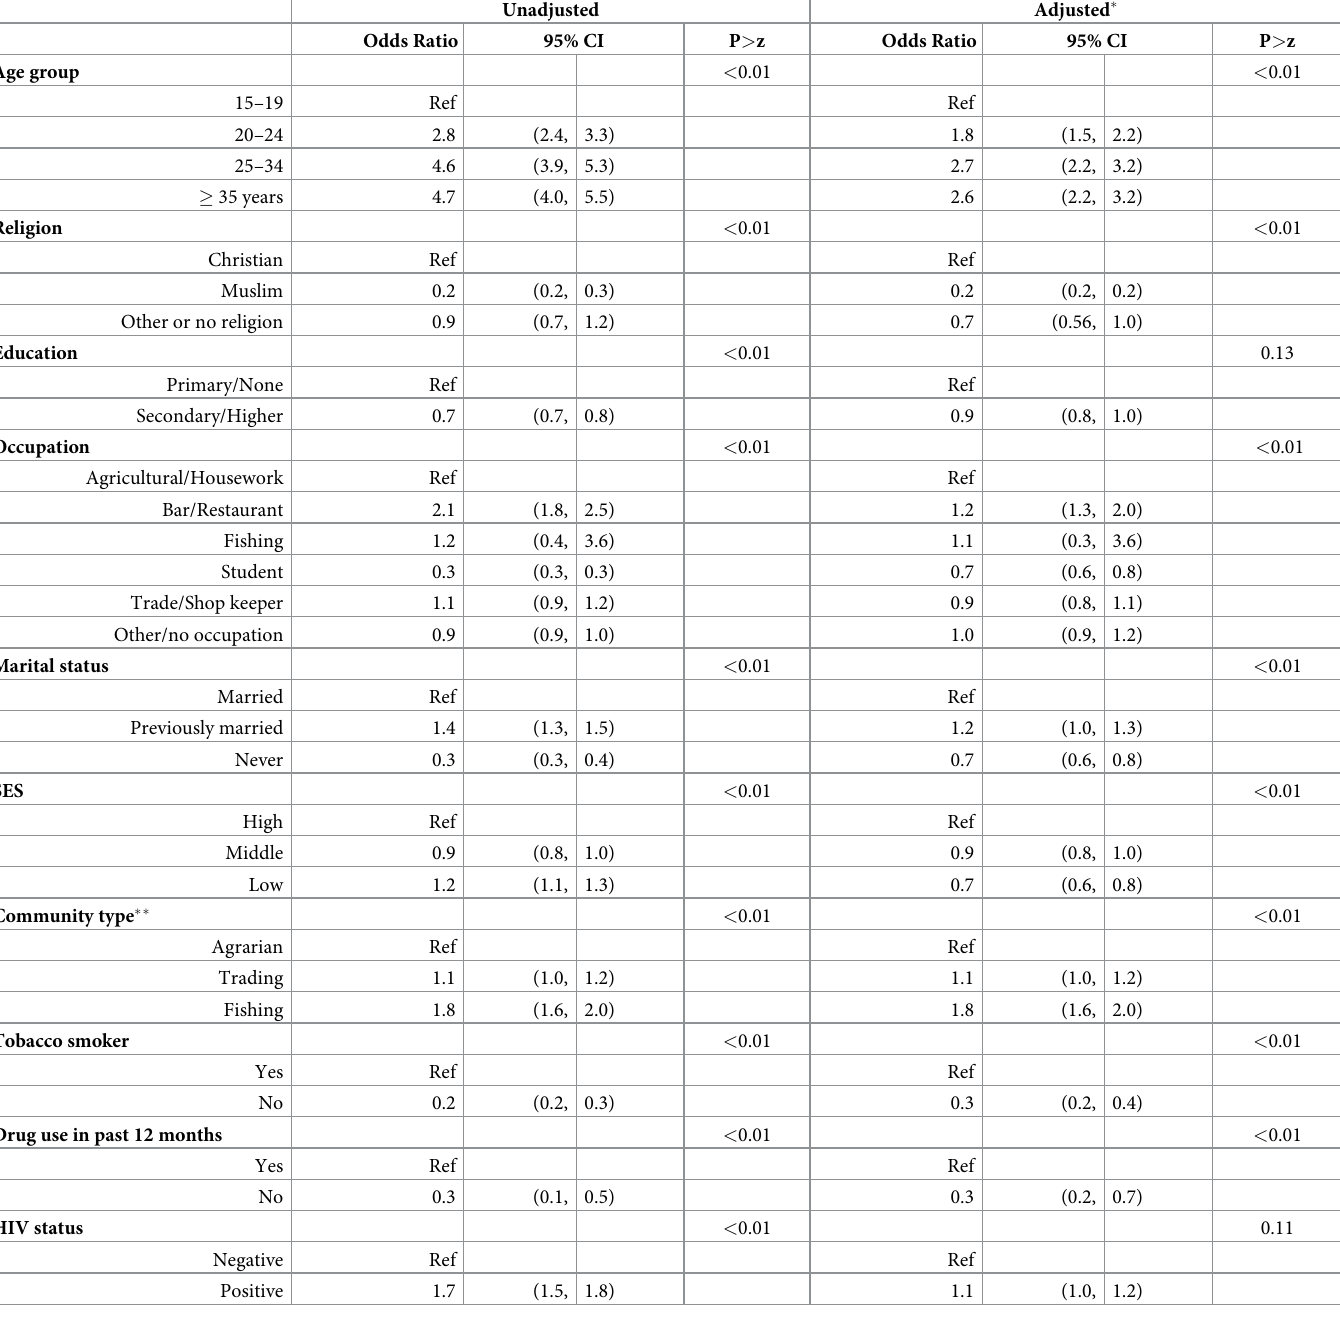
Table 4. Unadjusted and adjusted logistic regression models of correlates of alcohol use in the past 12 months in all women (N = 10,010) who participated in RCCS between March 2015 and September